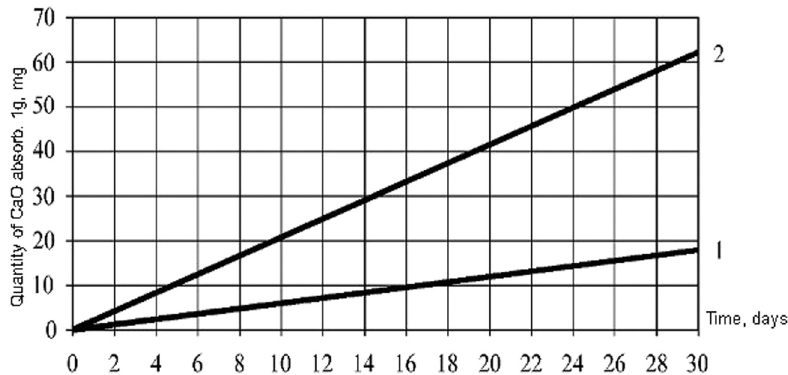
Figure 5: Activity of fi bers of fl y ash in relation to CaO, referred to 100 m 2 of surface. 1. Glass fi bers; 2. Fibers of fl y